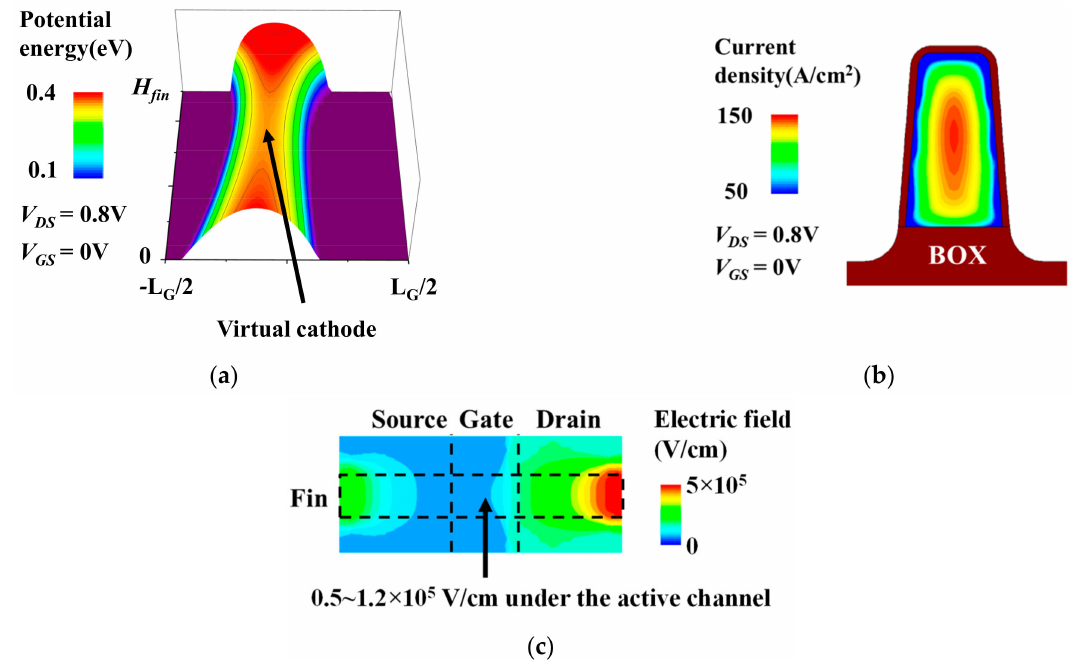
Figure 8. Simulation results of the 14 nm node SOI n-FinFET with the TID hardening design. ( a ) The potential energy distribution in channel region, ( b ) the sub-threshold current distribution in the tapered fin and ( c ) the distribution of the electric field in the BOX perpendicular to the channel/BOX